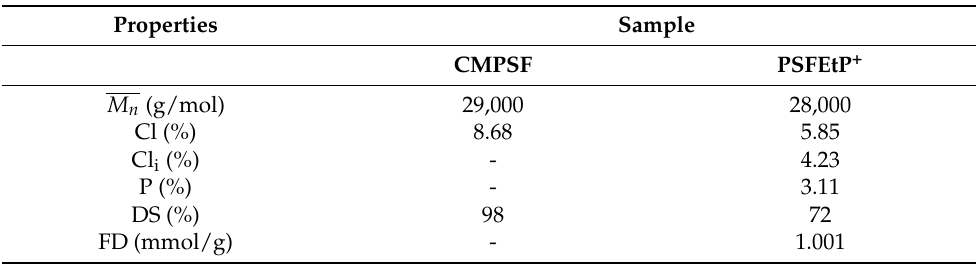
Table 1. Characteristics of the synthesized polysulfones: number-average molecular weights (M n ), total chlorine (Cl), ionic chlorine (Cl i ) and phosphorus (P) contents, substitution degree (SD), and functionalization degrees (FD) for chloromethylated (CMPSF) and functionalized polysulfone with triethylphosphonium groups (PSFEtP +